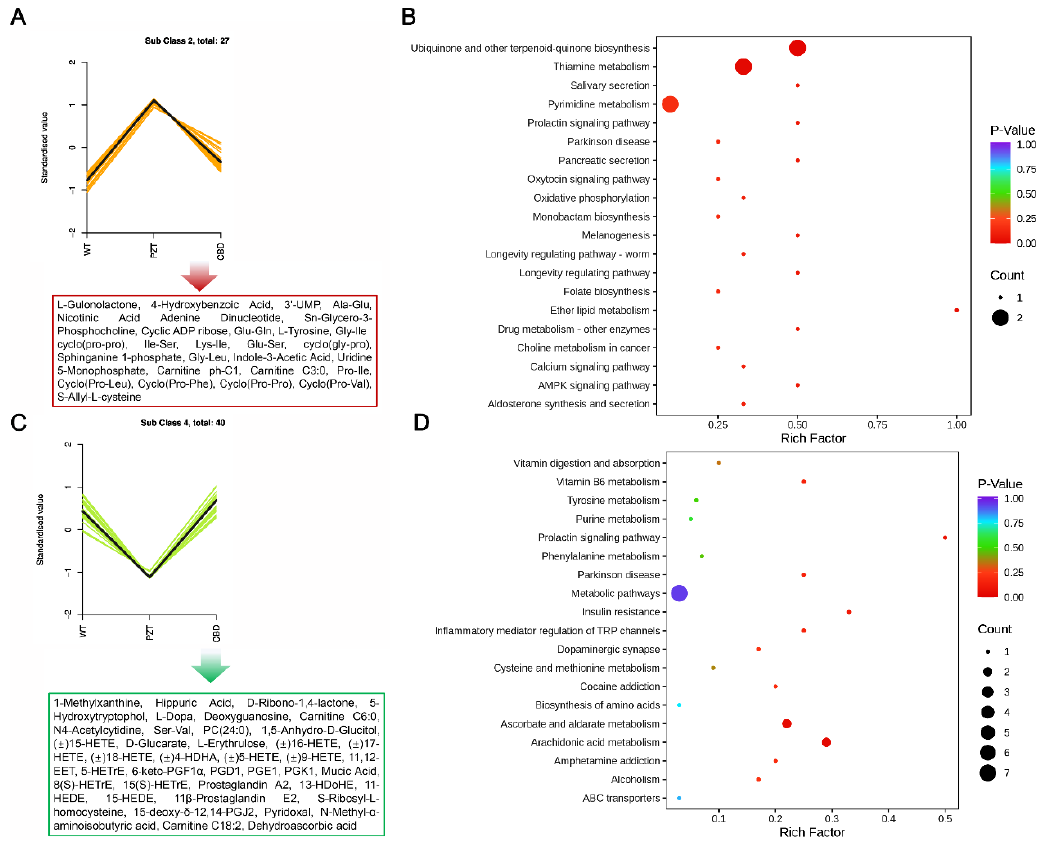
Figure 7. Metabolites fuzzy cluster analysis of the WT, PTZ , and CBD group. ( A ) The K - means clustering (K_means) analysis of 27 differential metabolites that were significantly increased in the PTZ group. ( B ) The KEGG pathway analysis showed the enrichment of the 27 differential metabolites. ( C ) The K - means clustering (K_means) analysis of 40 metabolites that were significantly up - regulated by the pre - exposure to CBD in the PTZ group. ( D ) The KEGG pathway analysis showed the enrichment of the 40 differential metabolites.